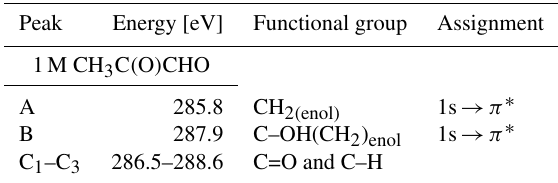
Table 4. Summary of the identified peaks of carbon K edge and the absorption energies for methylglyoxal in this